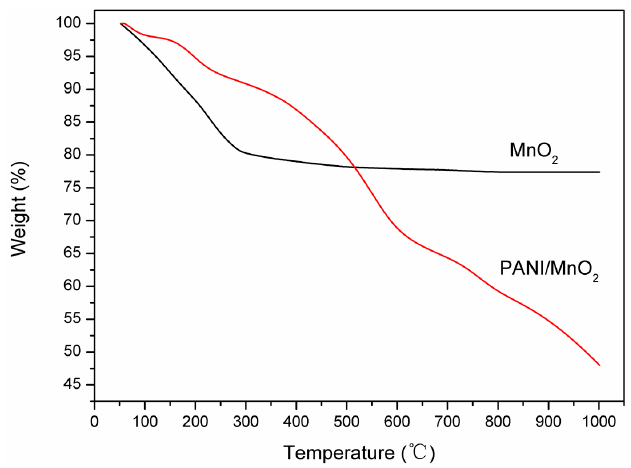
Figure 4. TG curves of MnO 2 and PANI/MnO 2 .